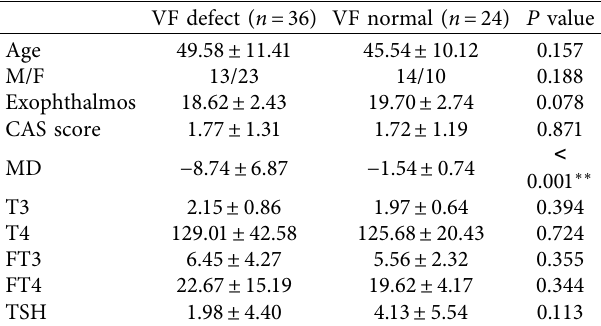
Table 1: Basic message of two groups.